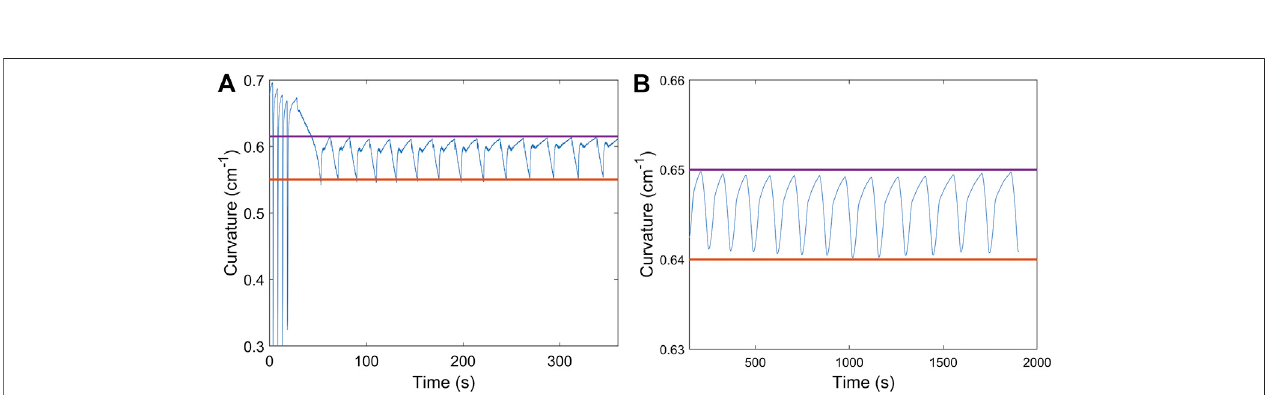
FIGURE 8 | (A) Curvature oscillation between 0.55 cm − 1 and 0.62 cm − 1 in partial cyclic actuation with limited current (1.4 A). Both sides of the controller were implementedontheactuatortoachieveautomaticallytuningontheactivationtimeandcoolingtime. (B) Curvatureoscillationwithin0.01 cm − 1 underthecurrentsituation of 0.8 A. The actuator visually maintained at a speci fi c location. In both fi gures, the two straight line indicates the assigned curvature range in the implementation of the closed-loop control strategy.